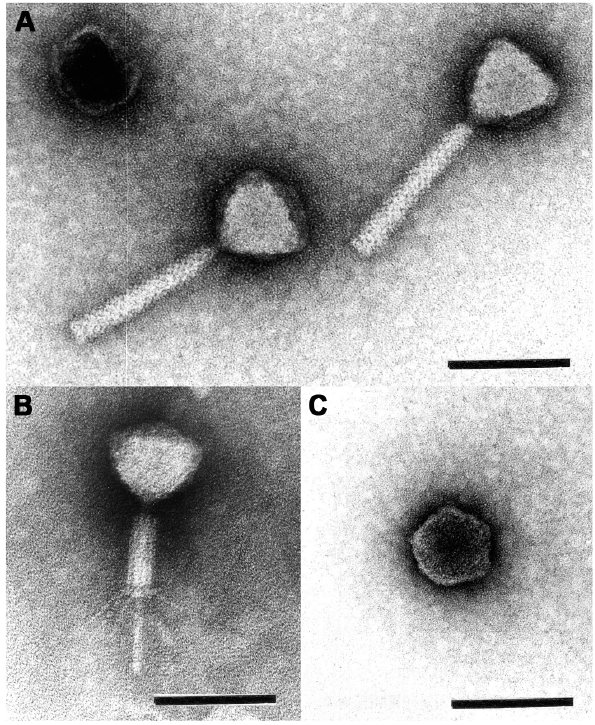
Figure 1. Electron micrographs of purified PaP1 phage particles. A shows two PaP1 particles with uncontracted tails and an empty head (uranyl acetate). B shows the contracted tail with straight tail fibers (phosphotungstate). C shows a pentagonal head (uranyl acetate). The scale bar represents 100 nm. These micrographs were taken by Hans-Wolfgang Ackermann, School of Medicine, Laval University, Quebec, Canada.